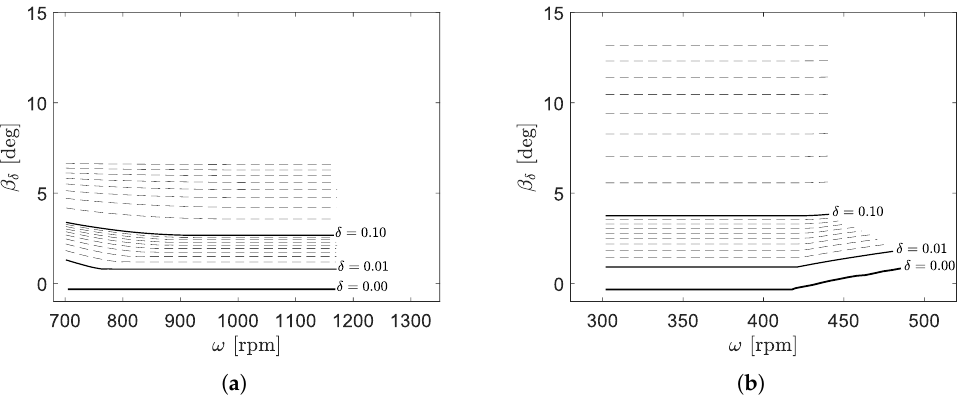
Figure 11. β δ ( ω , δ ) tables for NREL 5-MW ( a ) and DTU 10-MW ( b ) reference